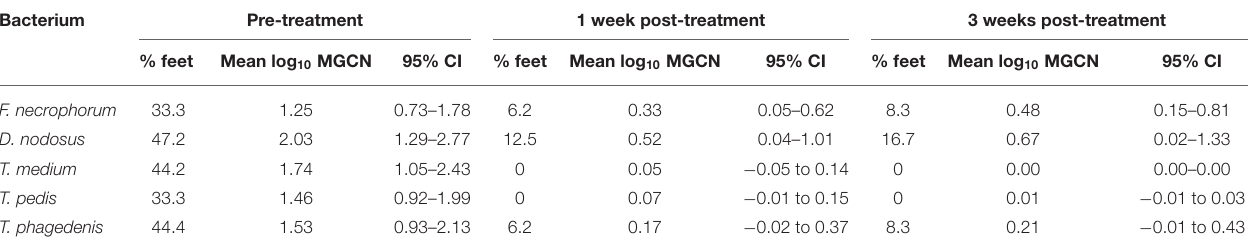
TABLE 4 | Percentage of feet colonized, mean (95% CI) foot level, and mean log 10 MGCN before and after treatment ( n = 12 feet). Bacterium Pre-treatment 1 week